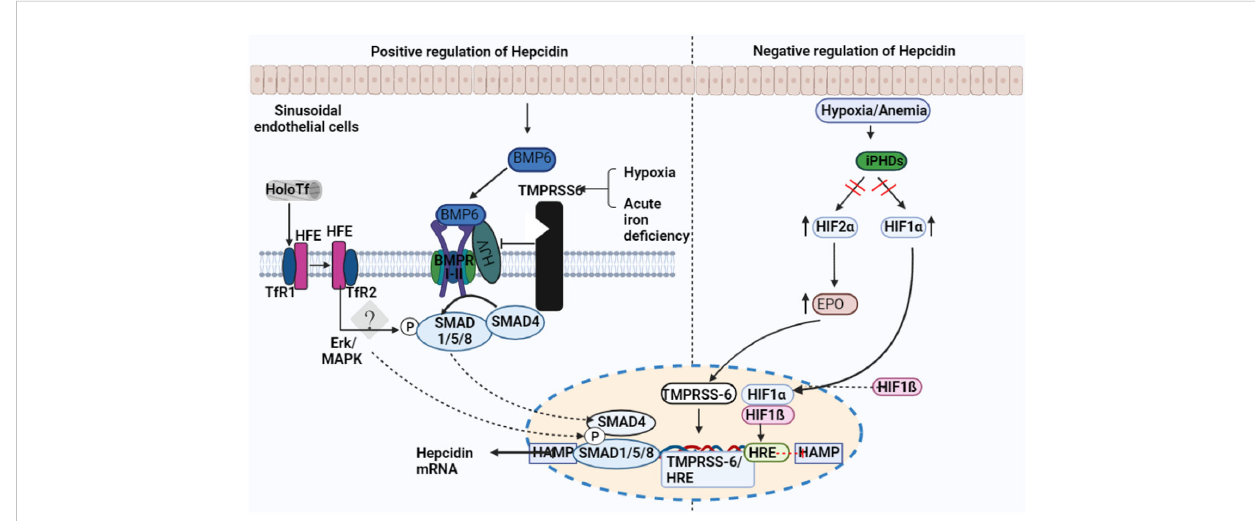
FIGURE 2 Factors regulating the expression of hepcidin. Transferrin receptor-1 binds Diferric (Holo) transferrin (TfR1). TfR1 induces HFE to interact with cell- surface-stabilized TfR2. Hepcidin transcription is regulated by the interaction between HFE and TfR2. Sinusoid endothelial cells (SEC) and other non- parenchymal cells produce BMP6 when intracellular iron is present. In order to activate BMP6, hemojuvelin (HJV) interacts with BMPRI-II, a receptor for BMP type I and II. The development of the hepatocyte multiprotein complex promotes the phosphorylation of SMAD1/5/8 and their interaction with SMAD4. The nucleus is where SMAD enters to activate hepcidin. The transmembrane serine protease TMPRSS6, which cleaves membrane HJV and suppresses hepcidin mRNA, is made more active by hypoxia and acute iron de fi ciency.